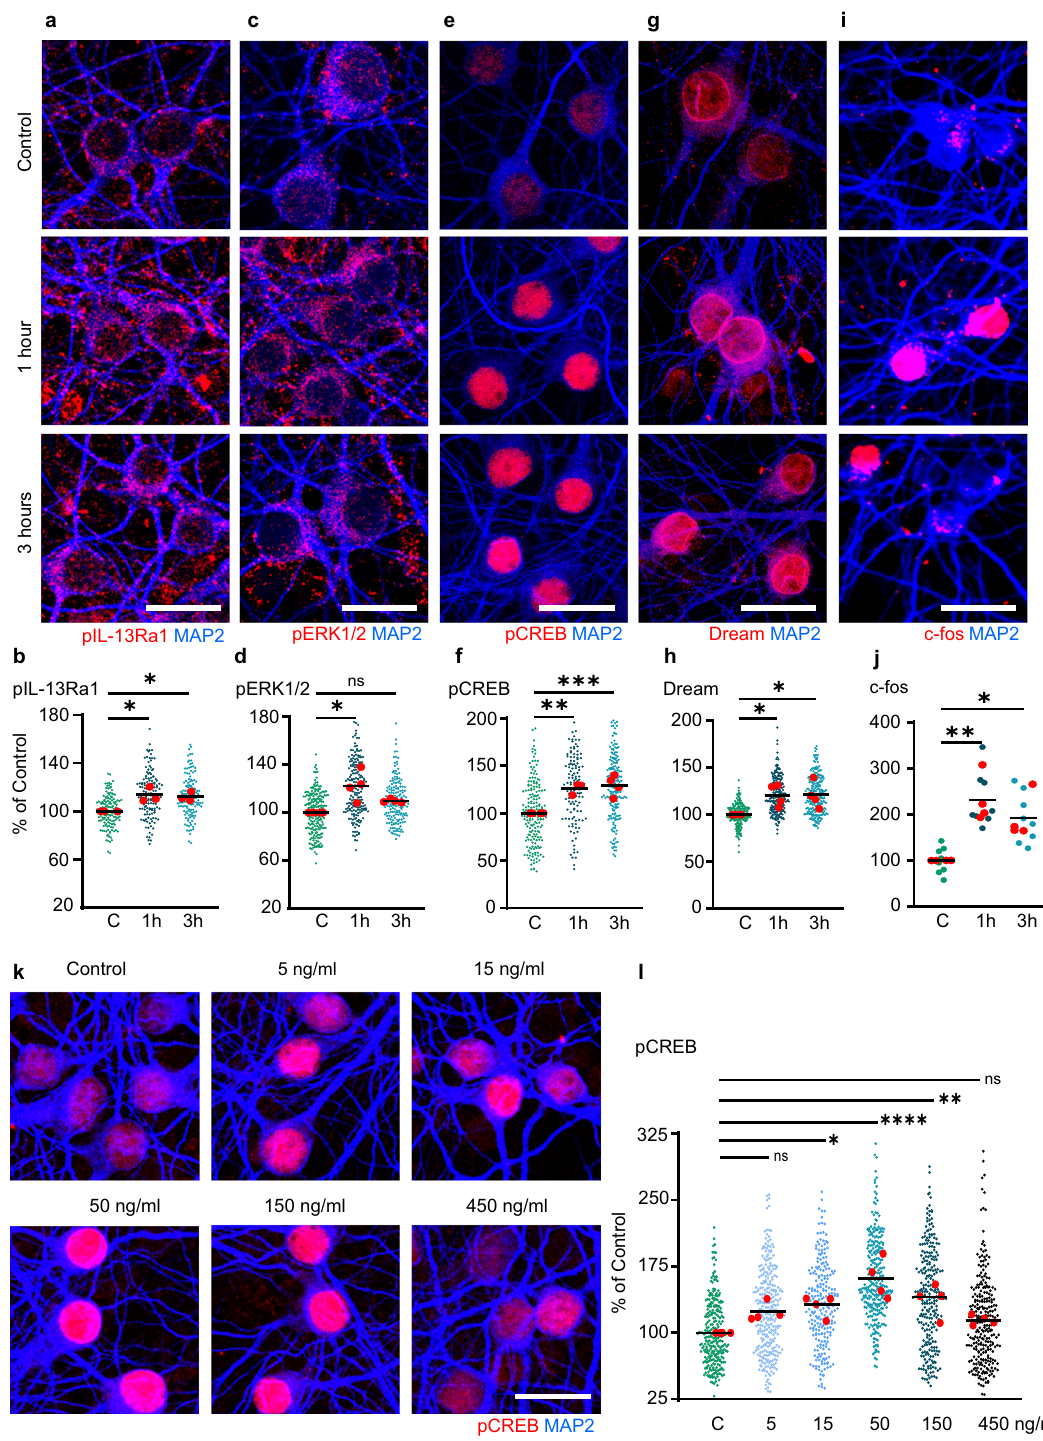
Fig. 4 | IL-13 induces CREB phosphorylation and immediate-early genes tran- scription.a , b Signi fi cantup-phosphorylationofIL-13Ra1inratcorticalneurons1h ( p =0.0147) and 3h ( p =0.0220) after IL-13 treatment (50ng/ml). N =3; n =C: 143; 1h: 137; 3h: 137 neurons. c , d Signi fi cant up-phosphorylation of ERK1/2 in rat cor- ticalneurons 1h ( p =0.0029) after IL-13 treatment (50ng/ml). N =4; n =C: 208;1h: 195; 3h: 161 neurons. e , f Signi fi cant up-phosphorylation of CREB in rat cortical neurons1h( p =0.0028)and3h( p =0.0008)afterIL-13treatment(50ng/ml). N =3; n =C:208;1h: 121; 3h: 187neurons. g , h Signi fi cant up-phosphorylation of DREAM in rat cortical neurons 1h ( p =0.0381) and 3h ( p =0.0387) after IL-13 treatment (50ng/ml). N =4; n =C: 232; 1h: 243; 3h: 246 neurons. i , j Signi fi cant increase of